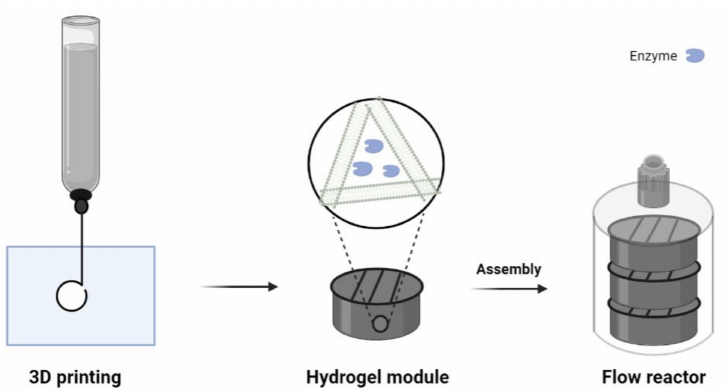
Figure 4. Diagram of the 3D printing process for enzyme